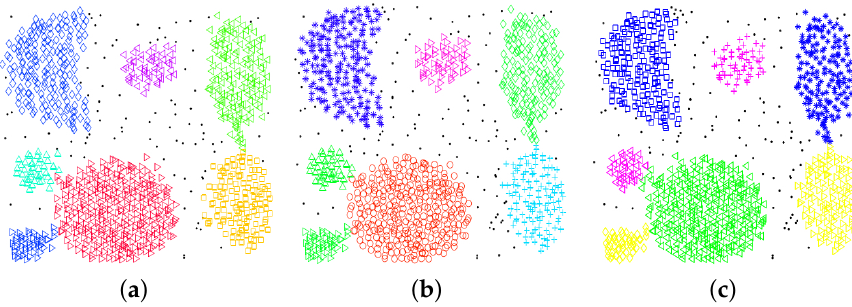
Figure 8. Influence of noise intensity on improved DBSCAN clustering effect. ( a ) noise = 100. ( b ) noise = 150. ( c ) noise =